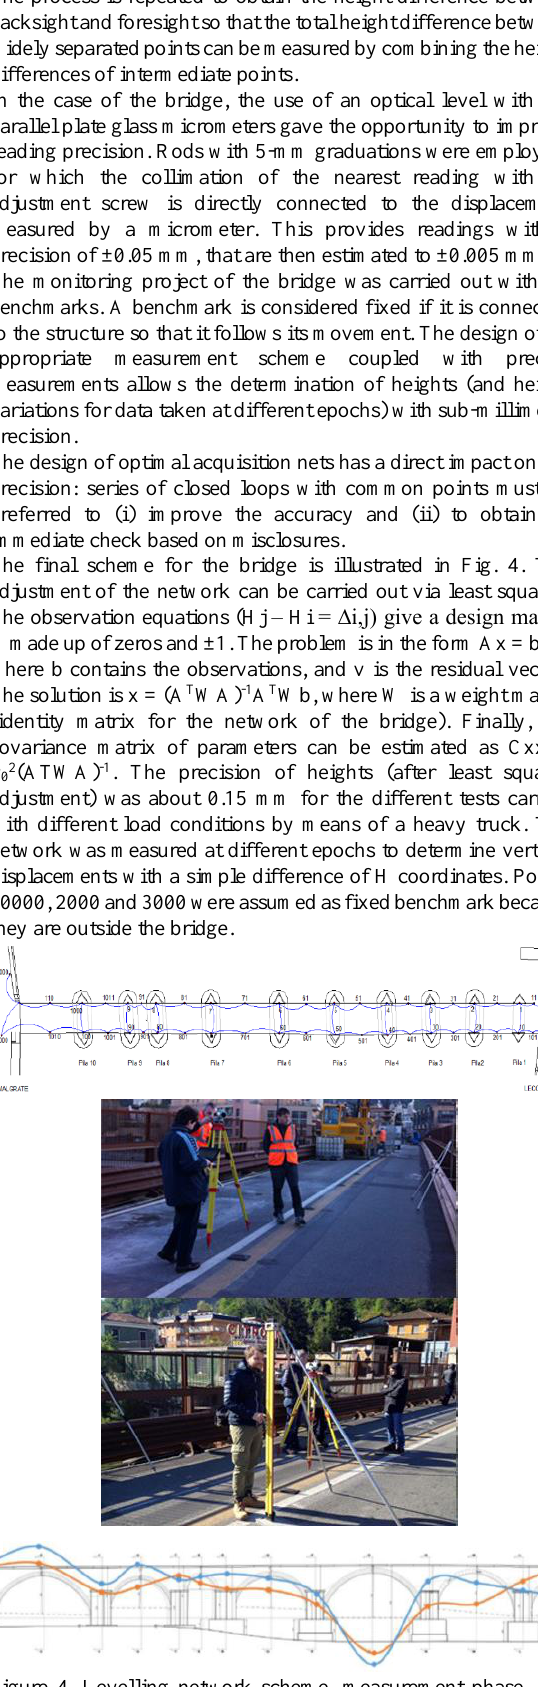
Figure 4. Levelling network scheme, measurement phase, and achieved graphic representation.